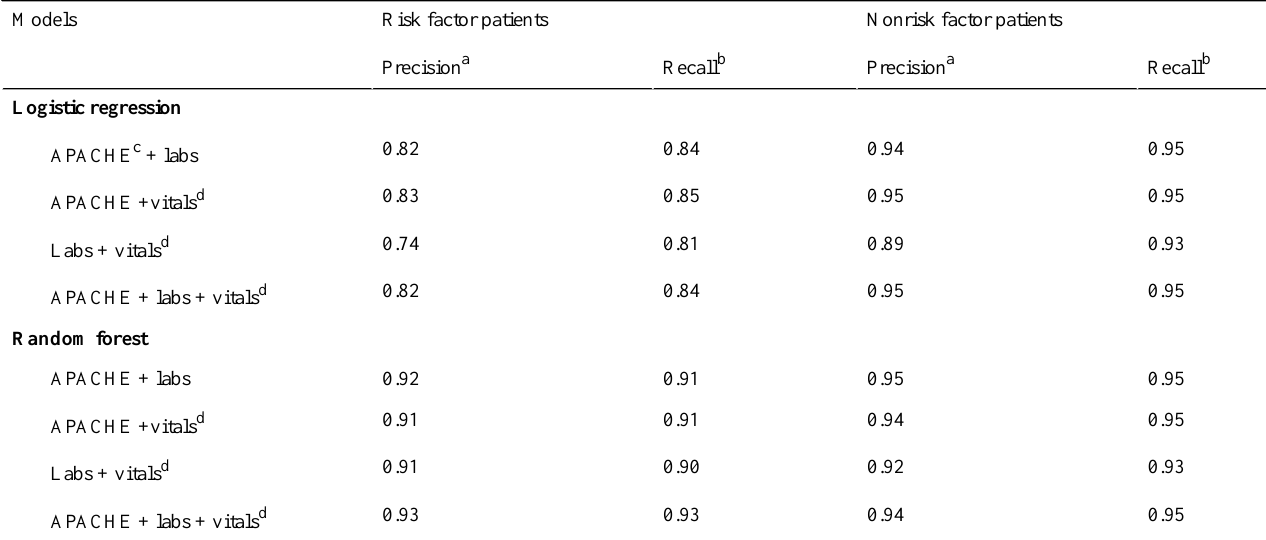
Table 5. Logistic regression and random forest precision and